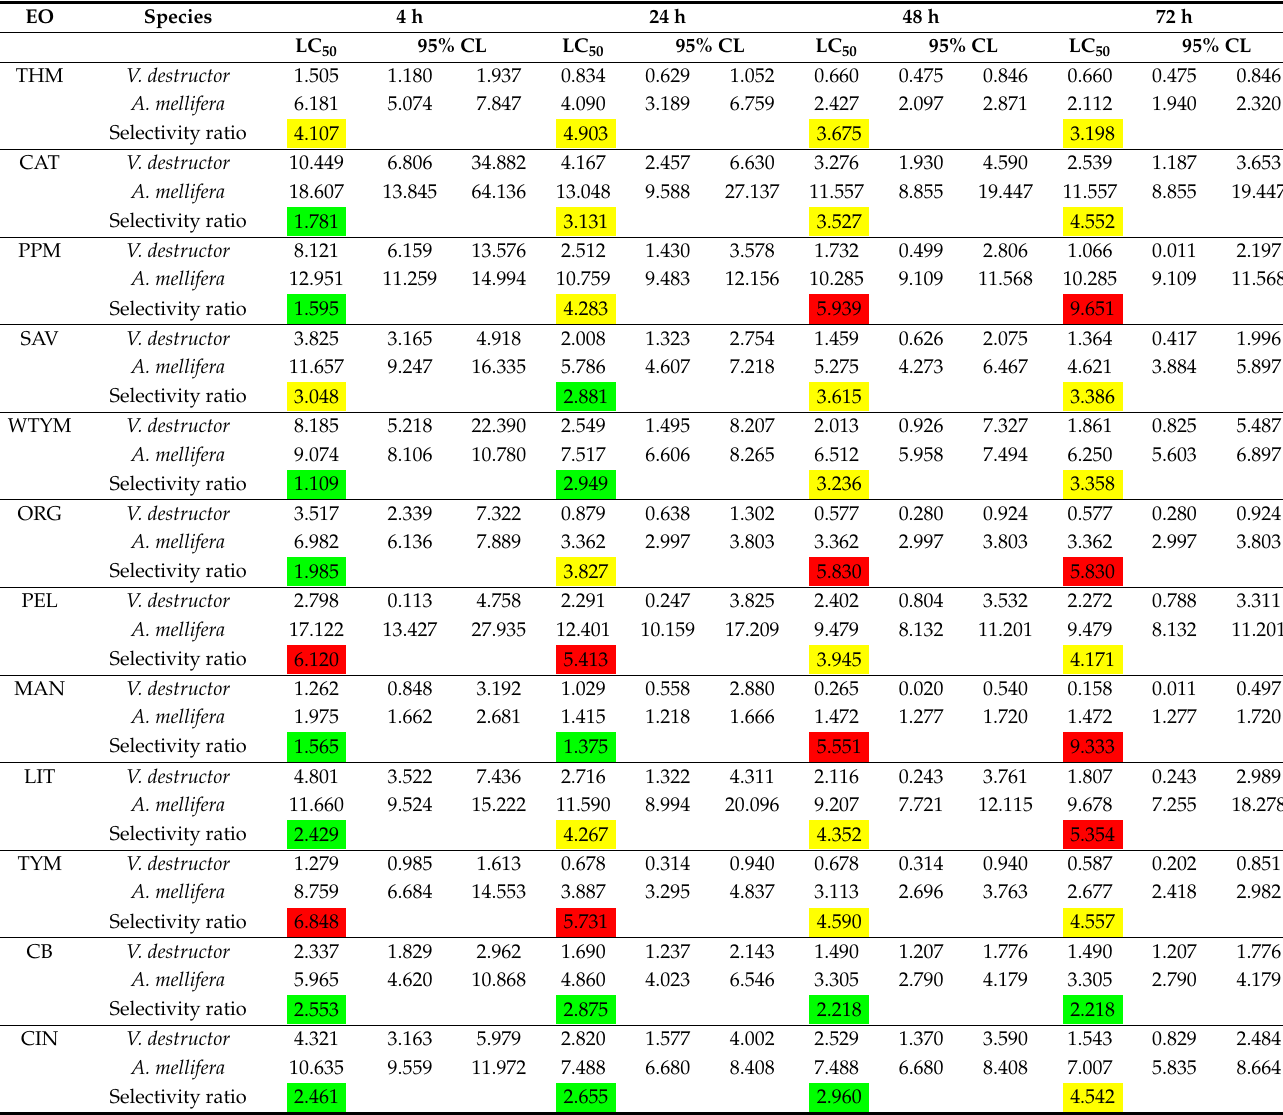
Table 2. Complete exposure bioassay. LC 50 ( µ L) of essential oils on V. destructor and A. mellifera and their selectivity ratio in a monitored period. Green highlighting means low value of selectivity ratio (<3), yellow highlighting means moderate value of selectivity ratio (3–5), and red highlighting means high value of selectivity ratio